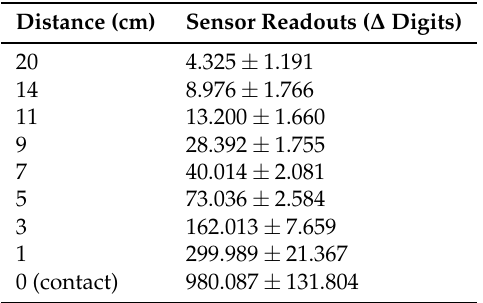
Table 2. “Pre-touch” experiment